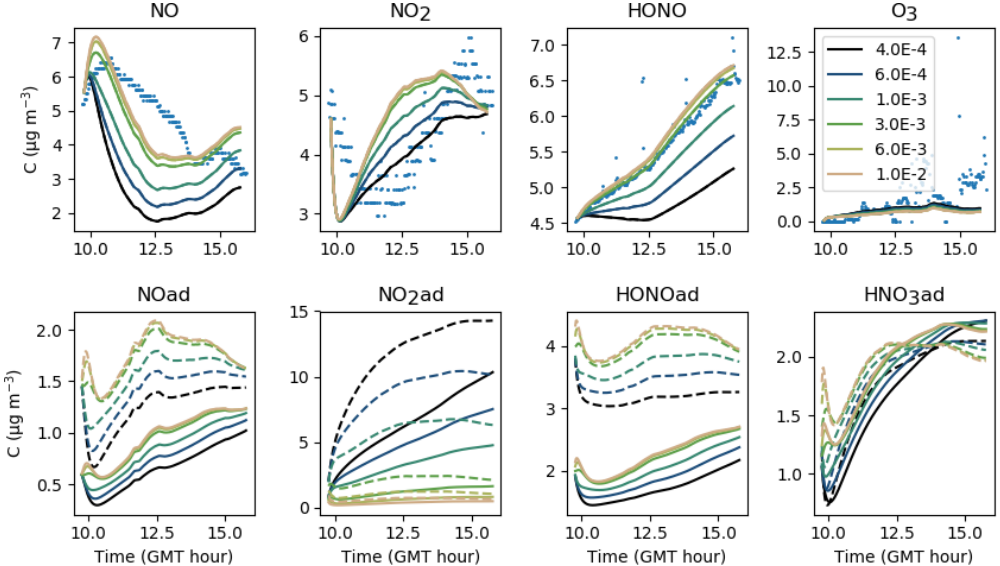
Figure 13. Gas-phase and adsorbed inorganic compounds simulated for different k S1 . The blue dots denote the experimental measurements (Experiment 2). The solid lines represent the concentrations in the sunlit box and the dashed lines the concentrations in the shaded